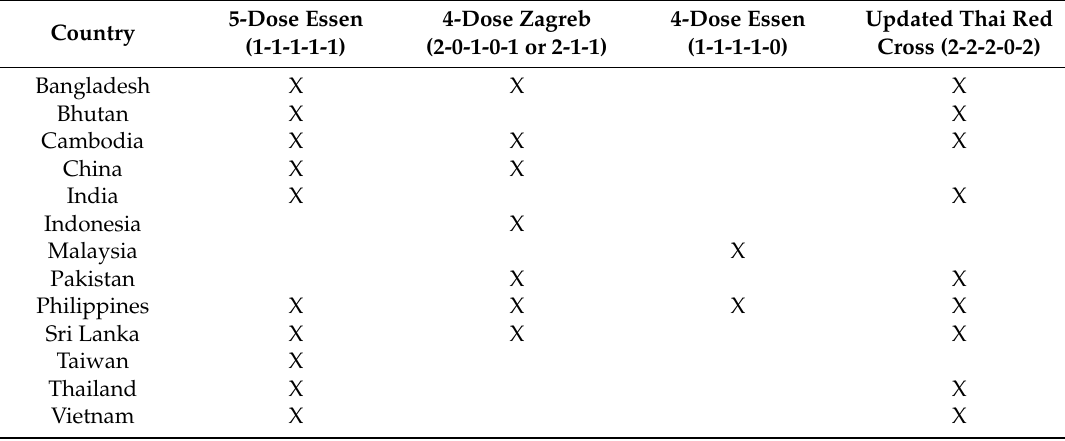
Table 3. National guidelines endorsing the WHO recommended PEP vaccination regimens: Essen, Zagreb, and the updated Thai Red